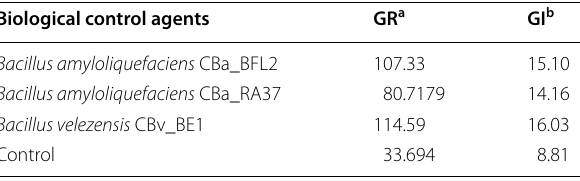
Table 5 Induced germination index and germination rate